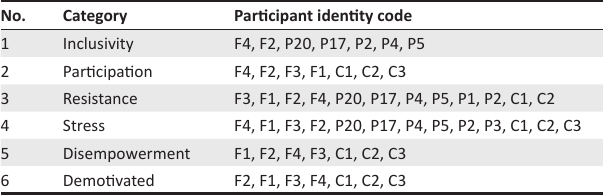
TABLE 1: Summary of categories